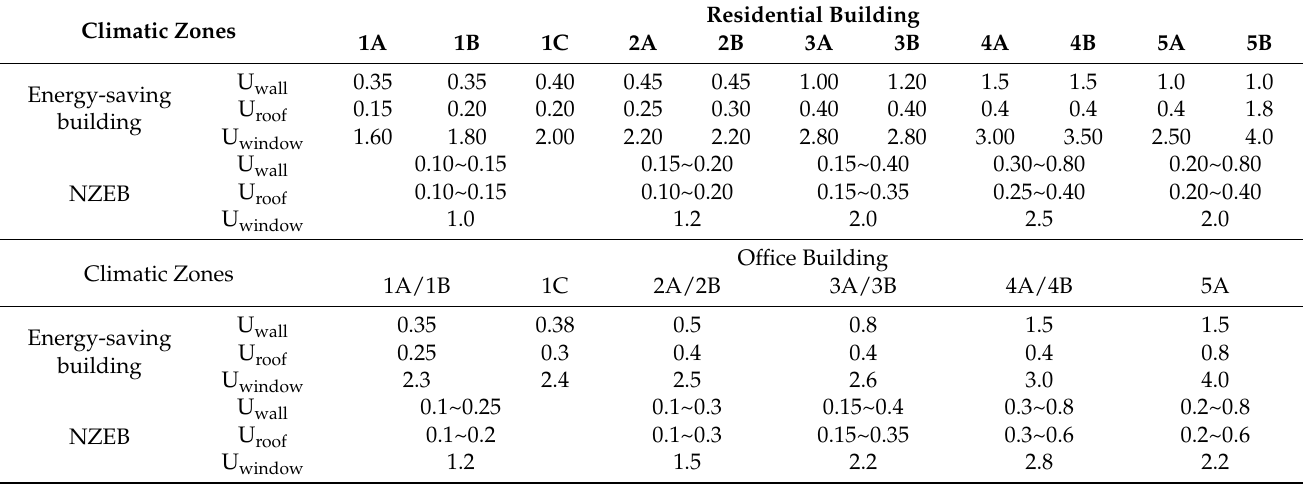
different climate zones under different